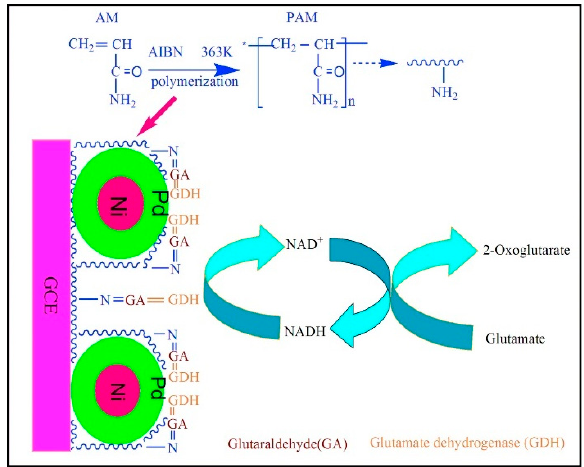
Figure 5. GlDH / NiePdePAM / GCE platform architecture. Reprinted from [156] with permission Figure 5. GlDH/NiePdePAM/GCE platform architecture. Reprinted from [156] with permission of of Elsevier.